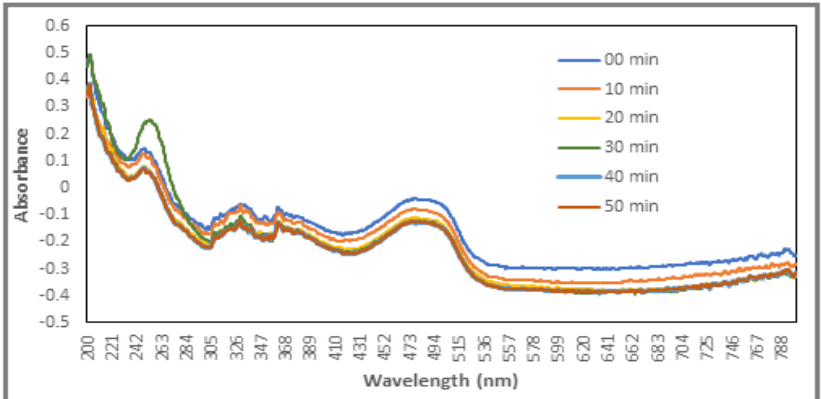
Fig. 5. Graphs showing the dye degradation in presence of FeCr